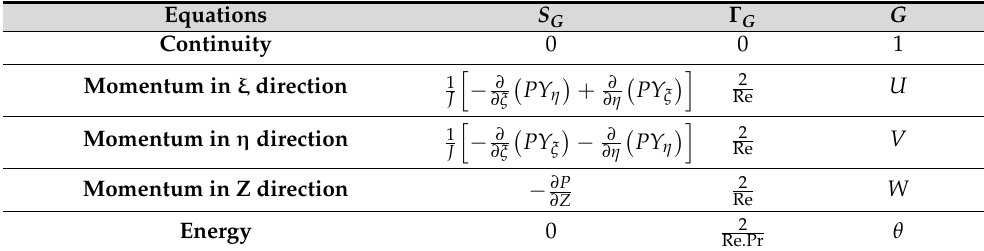
Table 2. Conservation equation parameters in computational